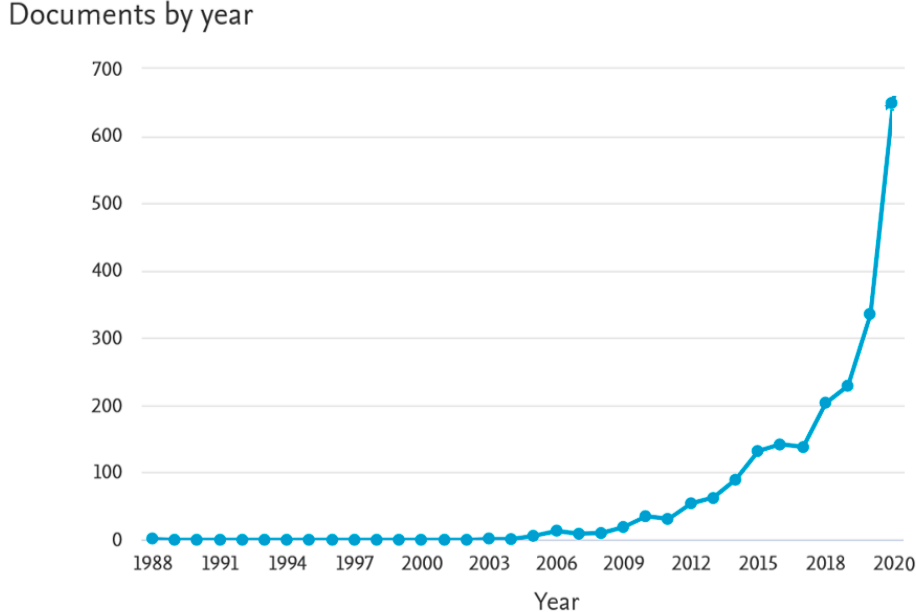
Figure 1. Publications on supply chain resilience in title, keywords, abstract in Scopus database, own work.